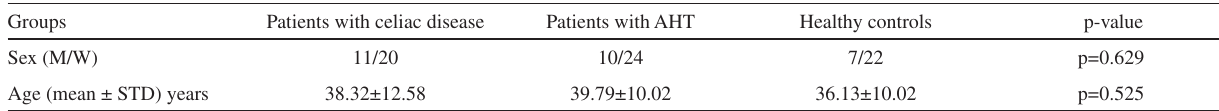
Table 1 - Demographic features of patients and healthy controls Groups